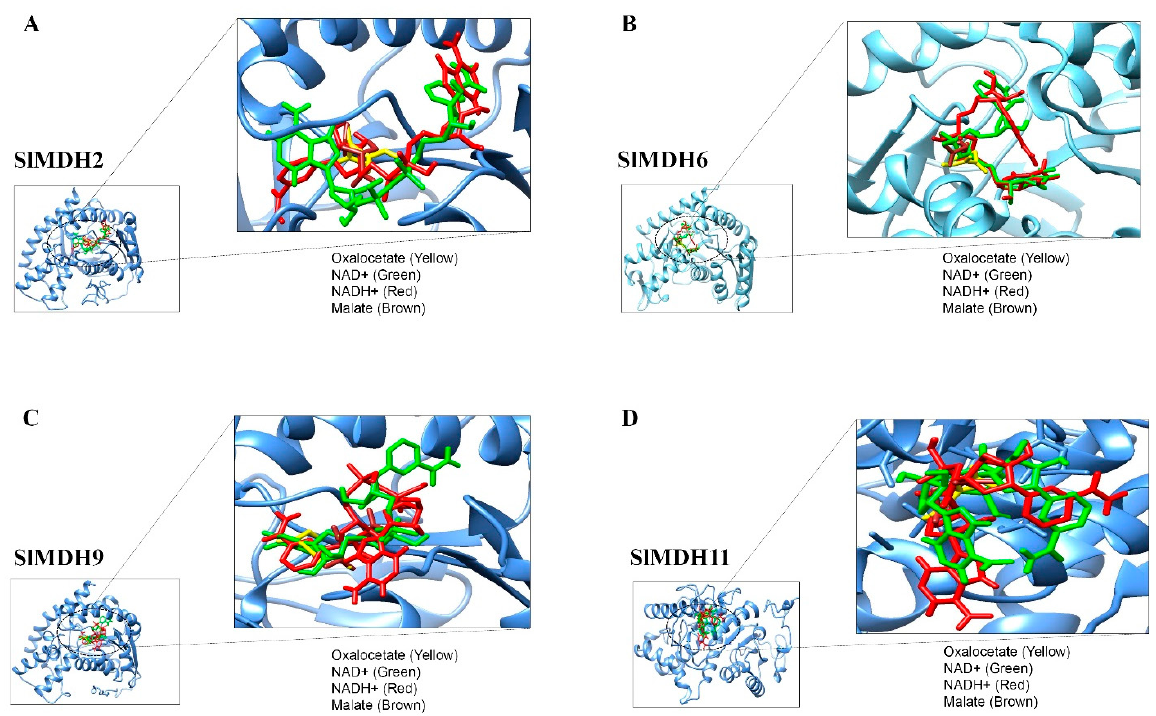
Figure 8. Molecular docking of Oxaloacetate (Yellow), NAD+ (Green), Malate (Brown) and NADH (Red) with SIMDH2 ( A ), SIMDH6 ( B ), SIMDH9 ( C ), SIMDH11 ( D ). The enzyme is shown in a blue cartoon while ligands are presented in different colors of sticks.